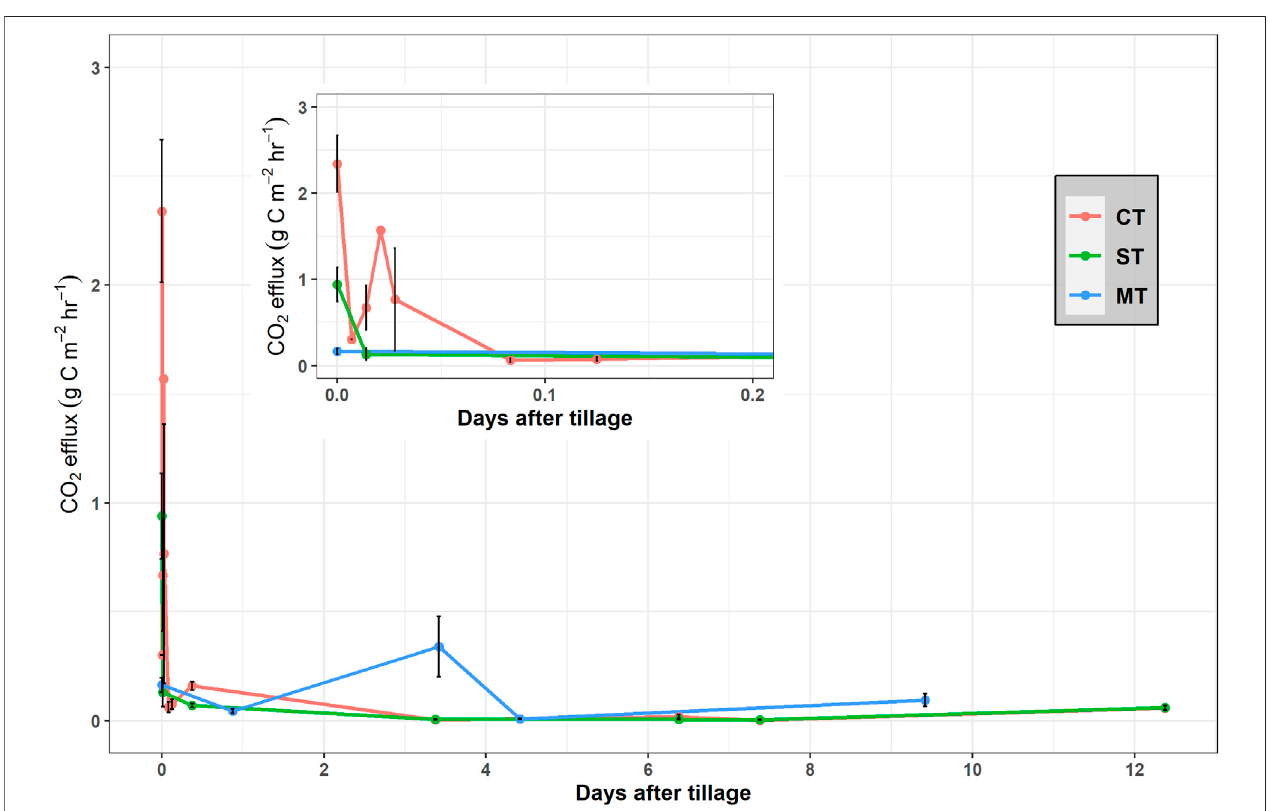
FIGURE2| Dailyairtemperature(blueline)andrainfall(greybars)recordedfromtheautomatedweatherstationatOakparkcoveringthe2-yearperiodfromsowing inExp.1toharvestinExp.2(August2014 – August2016).Theshadedredareasindicatethegasmeasurement periodsinExp.1(17/03/2015 – 21/07/2015)andExp.2 (27/02/2016 –